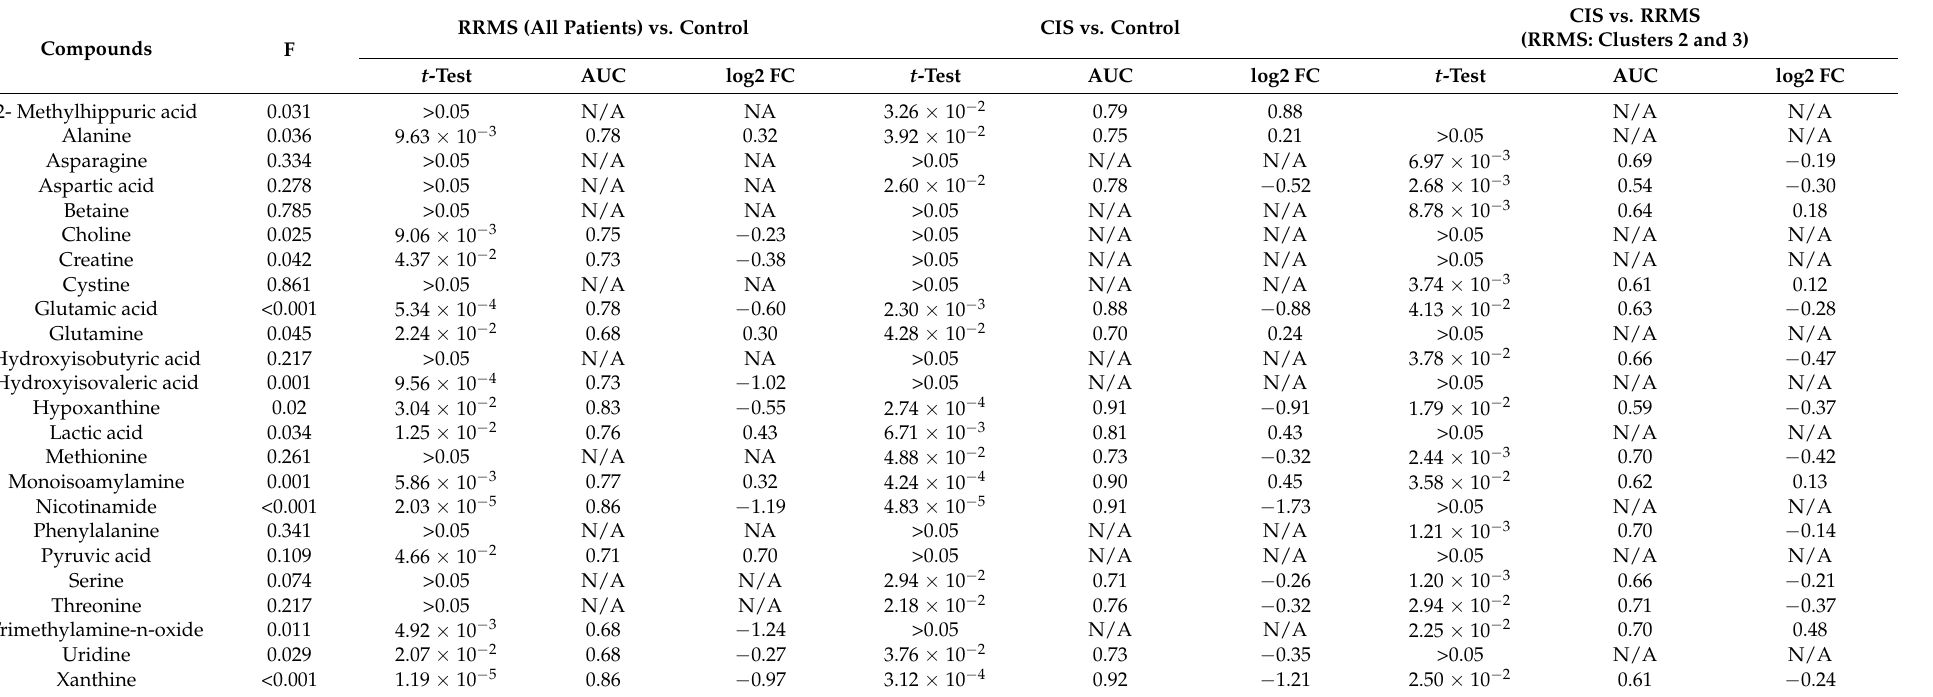
Table 2. Metabolites implicated in the differentiation between the studied